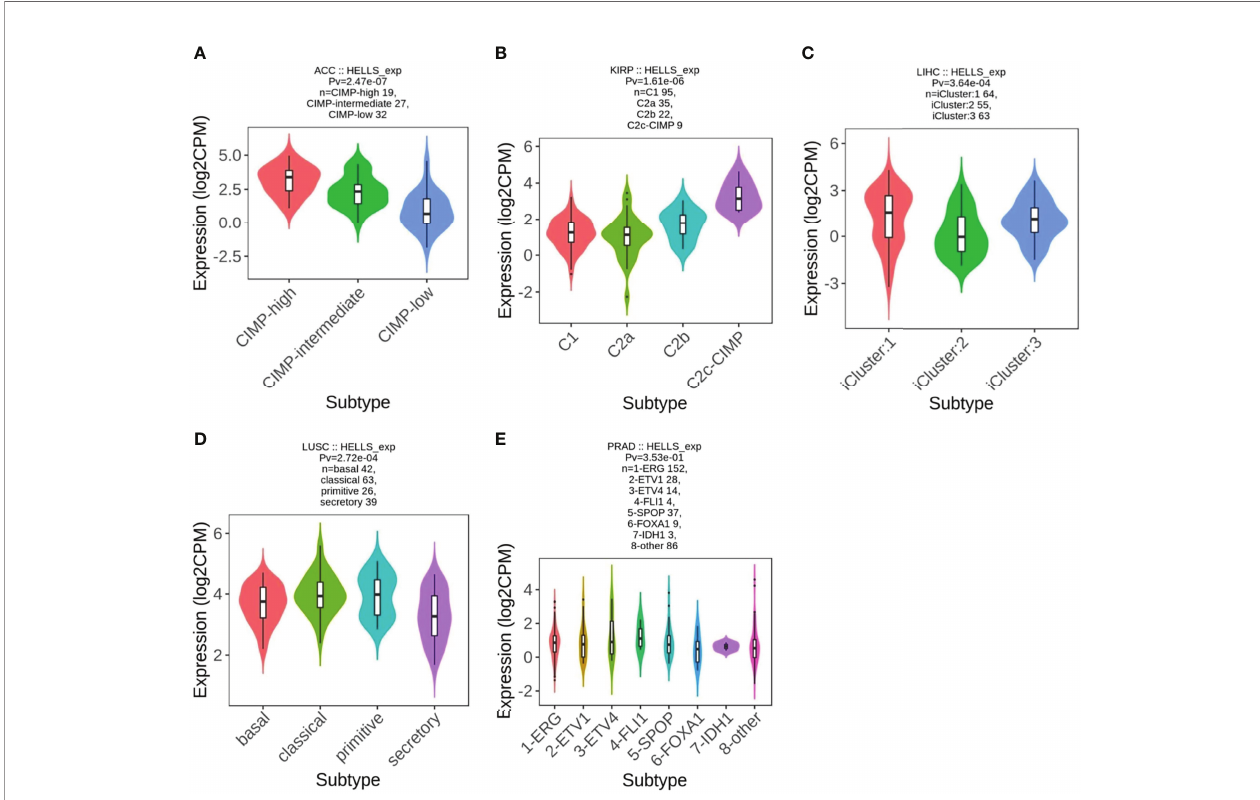
FIGURE 7 | Correlations between HELLS expression and molecular subtypes in 5 cancers. (A) ACC, (B) KIRP, (C) LIHC, (D) LUSC, (E)